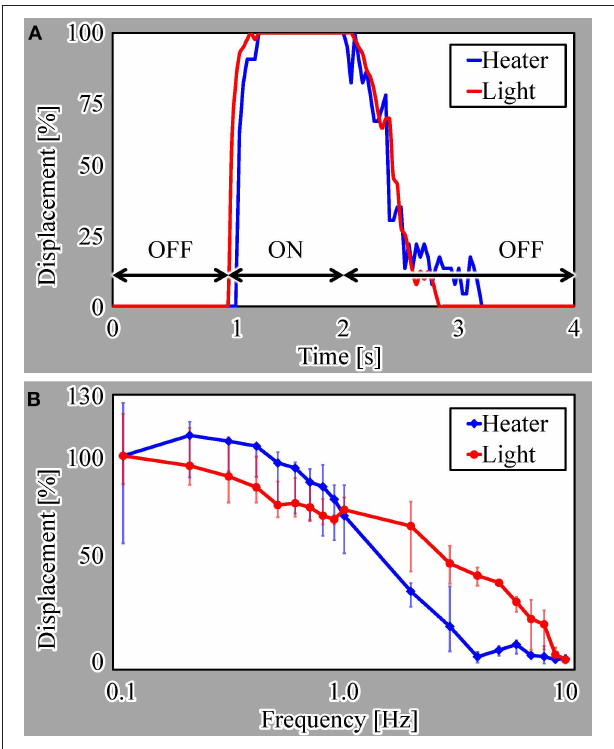
FIGURE 7 | Actuation characteristics of the actuators: (A) step response and (B) frequency response.